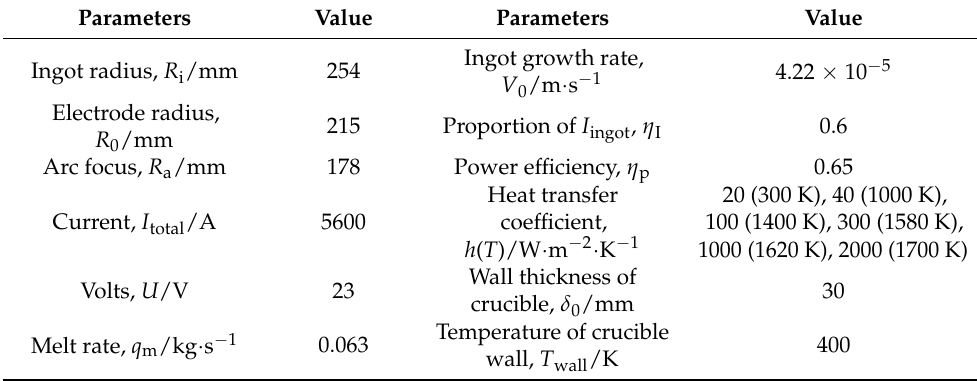
Table 1. Major technical parameters during the VAR process.